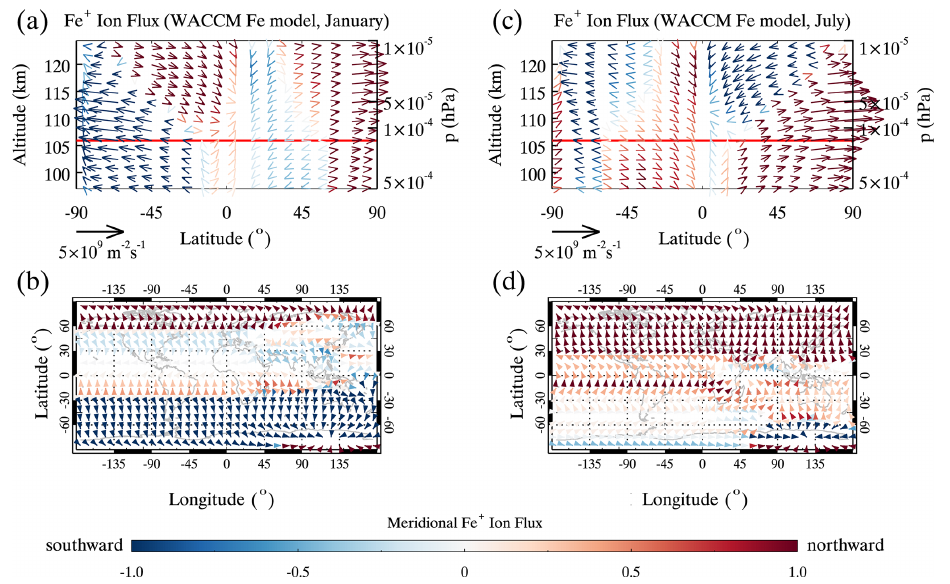
Figure 4. (a) Zonal mean latitude–height plot of Fe + flux (cid:56) Fe + (m − 2 s − 1 ) calculated offline from WACCM X and WACCM Fe in January, adding E × B drift, Coulomb force-induced ion drift, and neutral wind effects. The colour scale denotes the meridional Fe + flux and extends from − 1 (southward) to + 1 (northward). Also plotted are ion flux vectors that combine the meridional Fe + flux with the vertical Fe + flux. The horizontal red line represents the altitude of 106km at which the peak density of E s layer reaches its maximum value. (b) Map of Fe + flux at an altitude of 106km from the model in January. Panels (c) and (d) show a zonal mean latitude–height plot and map of Fe + flux, respectively, from the model in July.